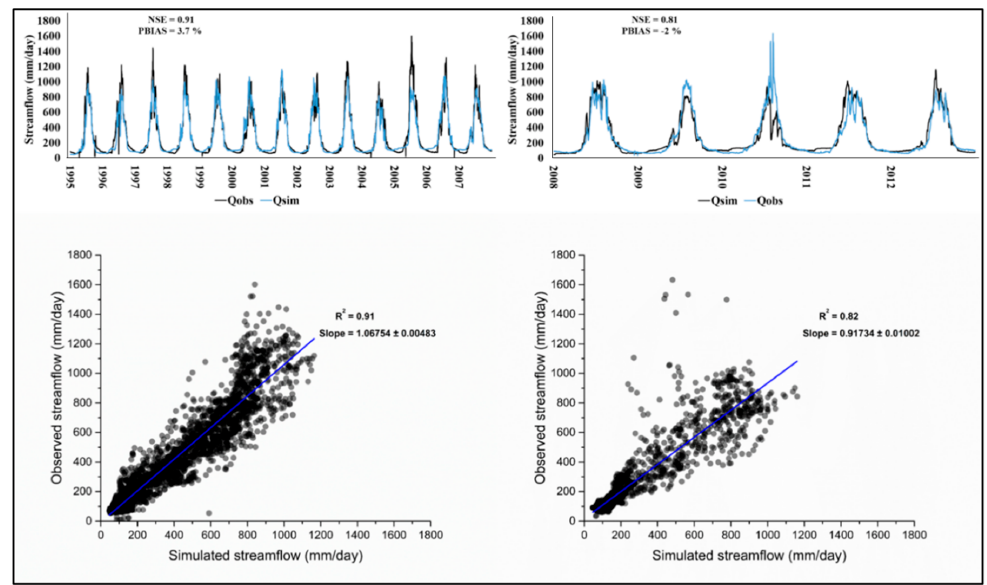
Figure 2. Top left: daily observed (black) and HBV-light simulated (grey) streamflow during the calibration period (1995–2007). Top right: as top left, but for the validation period (2008–2012). Bottom panels: measure of fit (including the R 2 coefficient) between daily observed and HBV-light simulated streamflow during the calibration (left) and validation (right) periods.